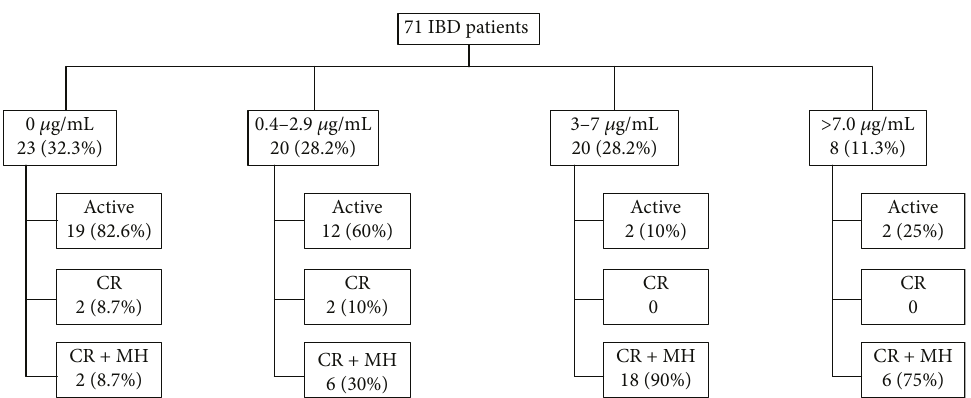
Figure 1: In fl ammatory bowel disease (IBD) patients according IFX trough levels and comparison between clinical remission (CR) and mucosal